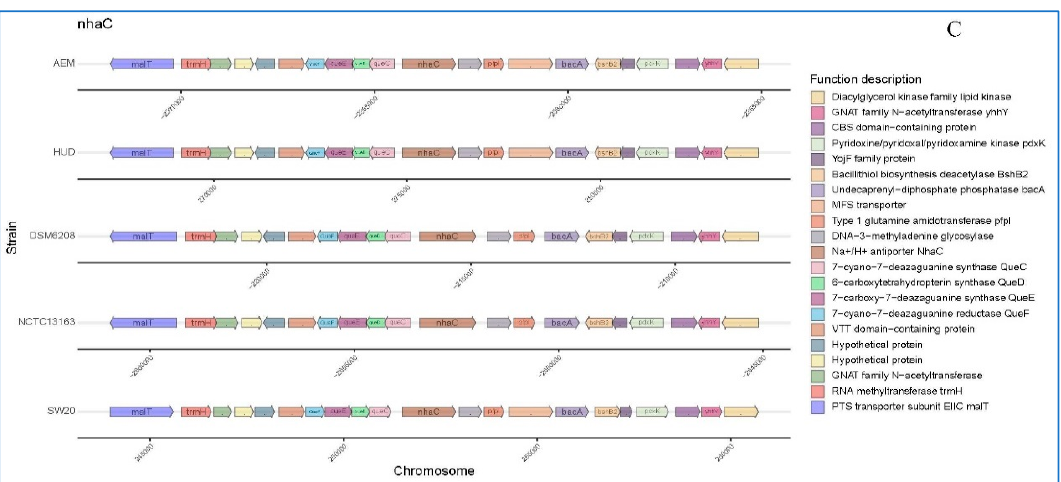
Figure 5. Schematic comparison of the three main gene clusters for different function based on annotations in the KEEG database: ( A ) Arsenic tolerance ( B ) Cytochrome P450 hydroxylase and ( C ) Na + /H + antiporter protein in E. aurantiacum SW-20, E. aurantiacum DSM 6208, E. aurantiacum NCTC13163, E. mexicanum A-EM and E. mexicanum HUD.